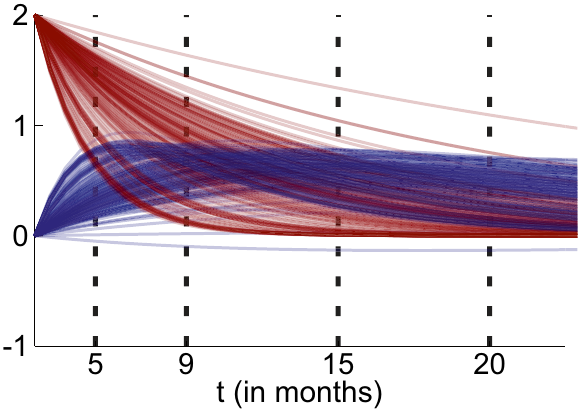
Figure 2. The artificial stress test induces a considerable amount of stress ( z sl i ,0 = 2 ) on each individualized ODE system and captures how the mental health (blue) and stressor load (red) are predicted to develop in the latent space (y-axis) over time (x-axis). Prediction targets are derived from the values of mental health at predefined time points (ptp 1-4) of 5, 9, 15 and 20 months.